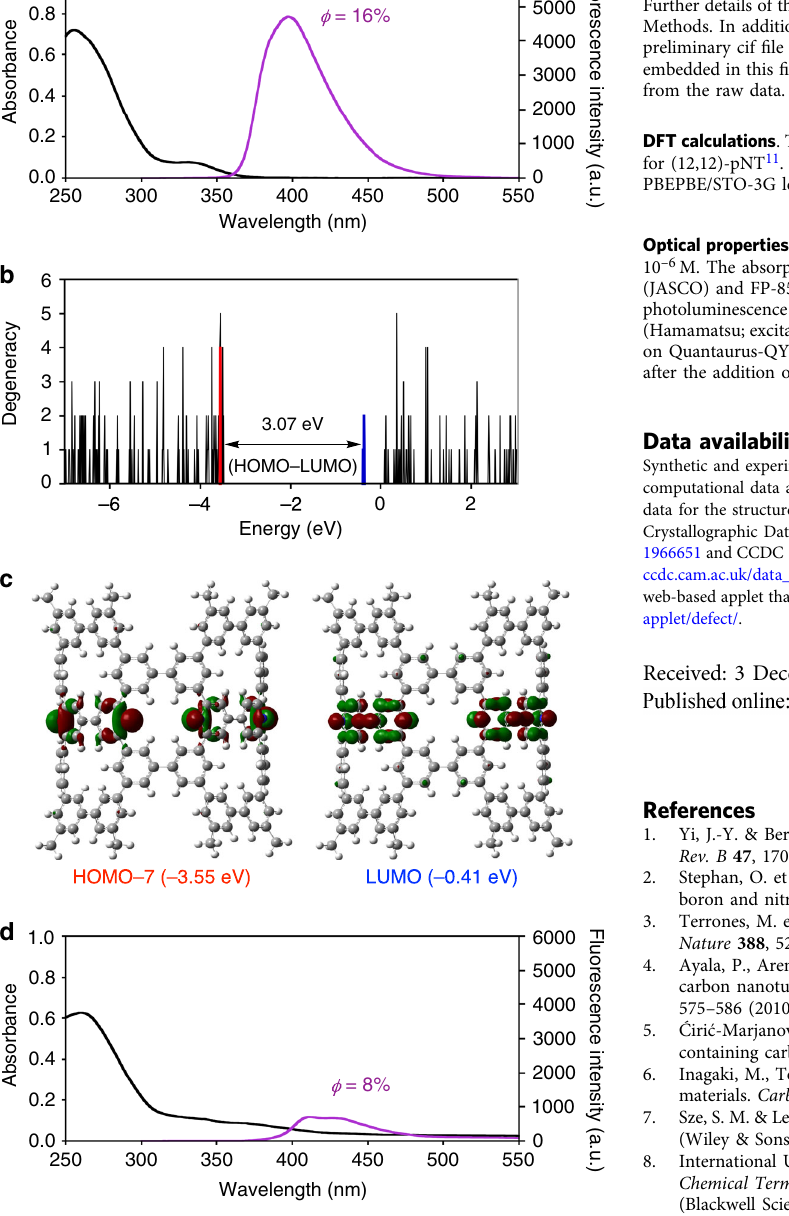
2 Cl 2 , 25 °C). 2 Cl 2 , 25 °C) in